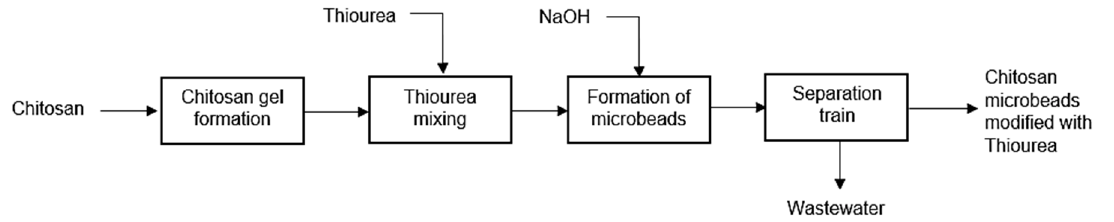
Figure 3. Process diagram of large-scale production of chitosan microbeads modified with thiourea .